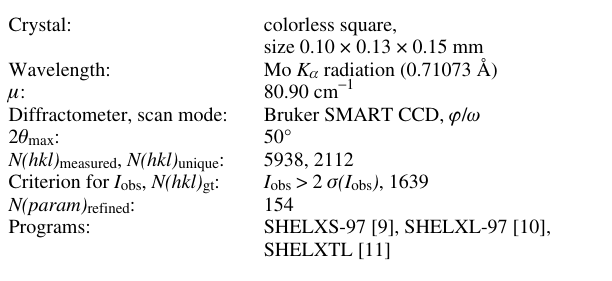
Table 1. Data collection and handling.